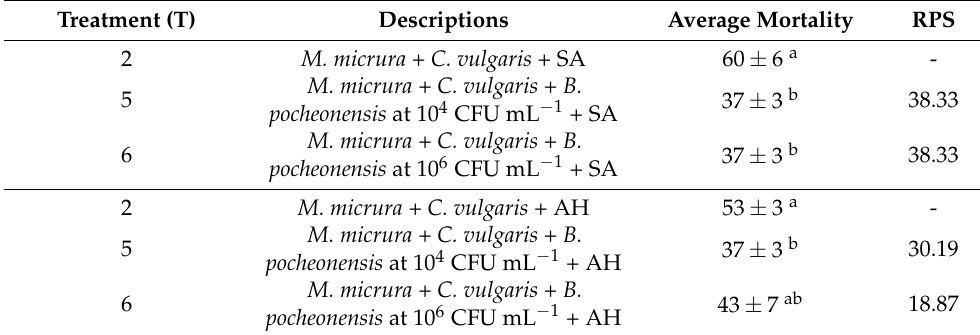
Table 2. Mortality (%) and relative percentage survival (RPS) of Moina micrura treated with Bacillus pocheonensis after 72 h post-challenge with Streptococcus agalactiae (SA) and Aeromonas hydrophila (AH). Treatment